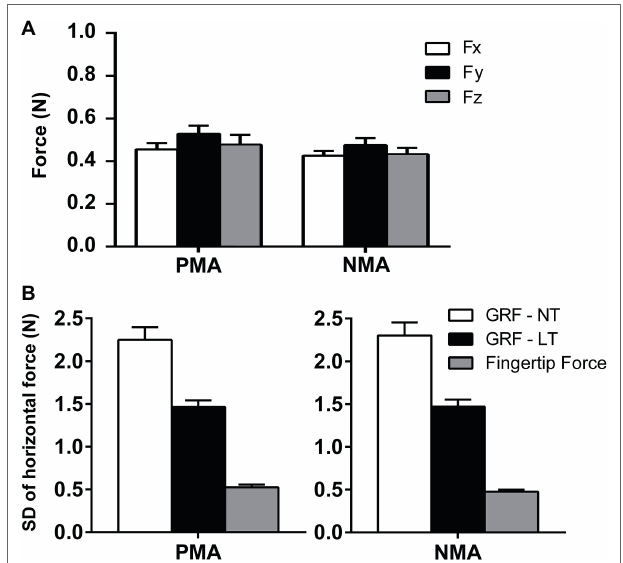
FIGURE 2 | Fingertip and ground reaction forces (GRFs) measured across the experimental conditions. (A) Vertical (Fz) and horizontal (Fx and Fy) forces (M ± SEM) applied to the MFP during the LT conditions. There were no statistical differences for the force values between the PMA and